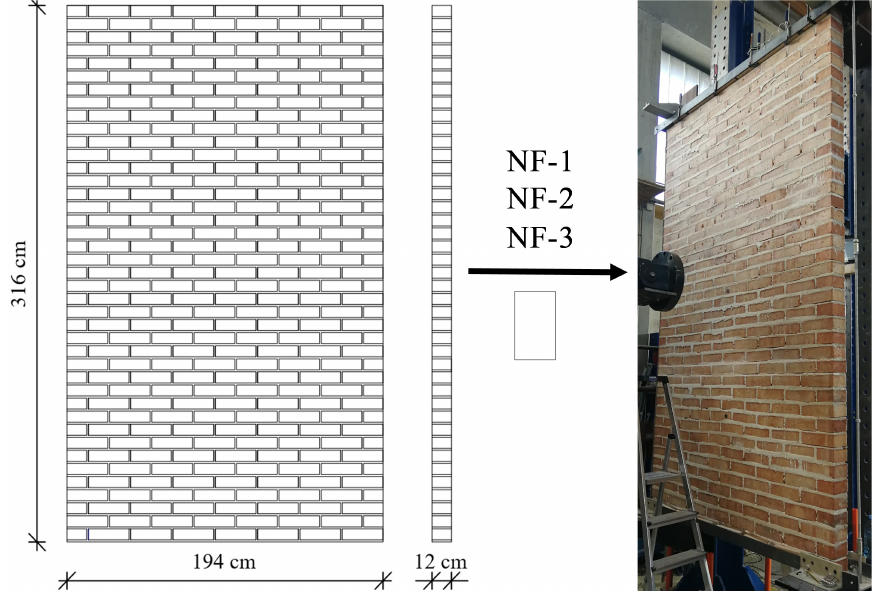
Figure 1. Geometry of a non-strengthened NF